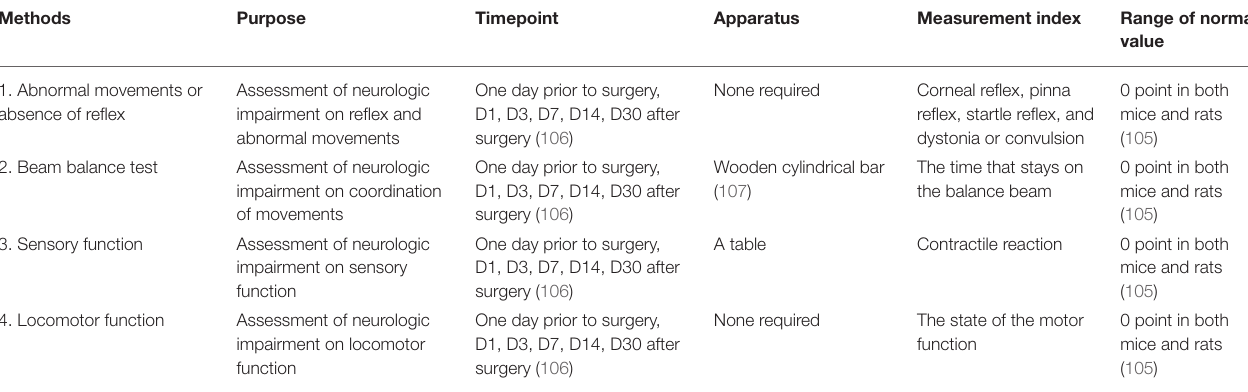
TABLE 3 | The modified neurologic severity score